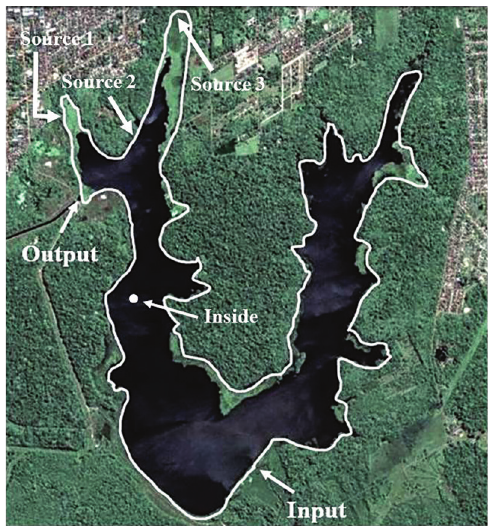
Figure 3 - Água Preta lake